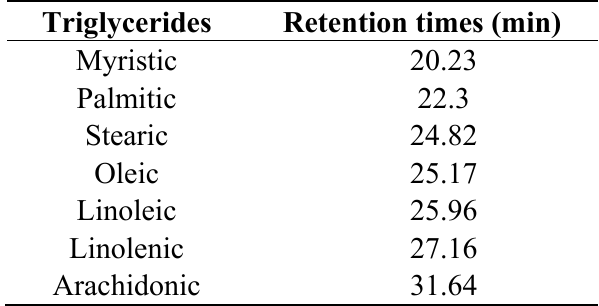
Table 2. Retention times of the FAMEs.